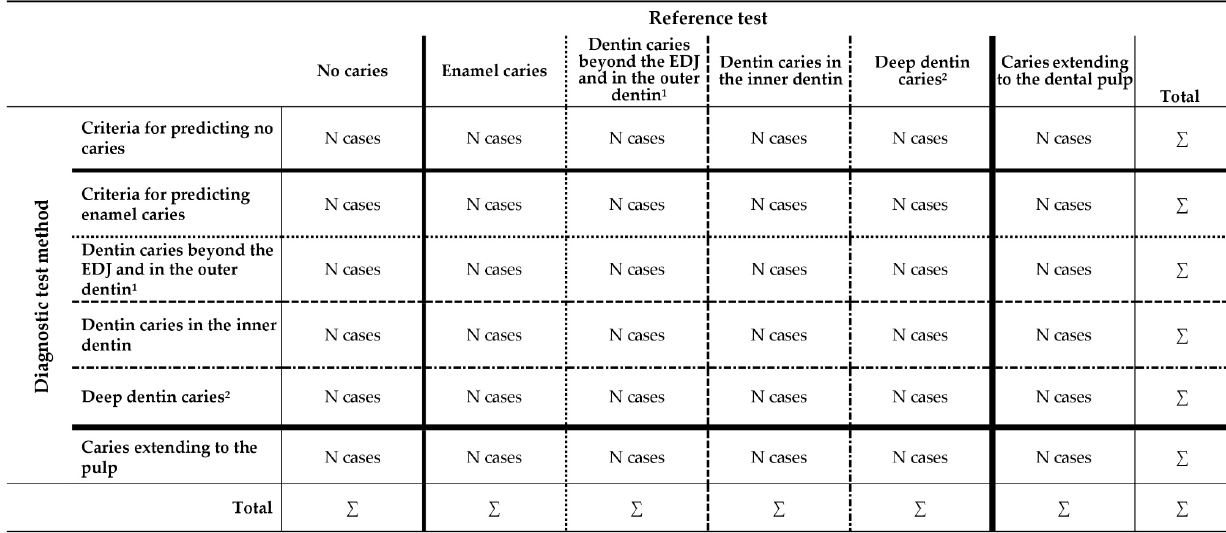
Figure 2. 6 × 6 contingency tabulation for potential use in future caries detection, diagnostic, assessment and/or monitoring studies that enables a complete reporting of all caries stages. It is important to recognize that different thresholds need be used for predicting different caries stages, e.g., caries detection level (bold line), dentin caries detection level (dotted line), outer dentin caries level (dashed line), deep dentin caries detection level (dash-dotted line) or caries involving the pulp (jagged line). 1 There is no exact definition for the metric extent of the “outer dentin”, and different proposals have been made, e.g., 33% [21] or 2 mm [37]. Other thresholds might also be possible. 2 A deep dentin caries lesion reaches the inner quarter of the dentin [38].